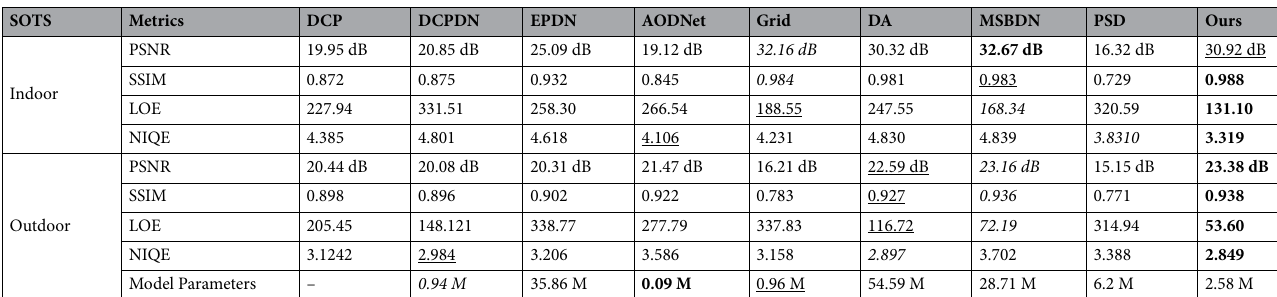
Table 1. Quantitative comparison results on the SOTS outdoor datasets. Number in bold, italics, and underline indicate the first, second, and third best results, respectively. DCP is a prior-based method without model parameters. Higher values of PSNR and SSIM; and lower values of LOE and NIQE represent better